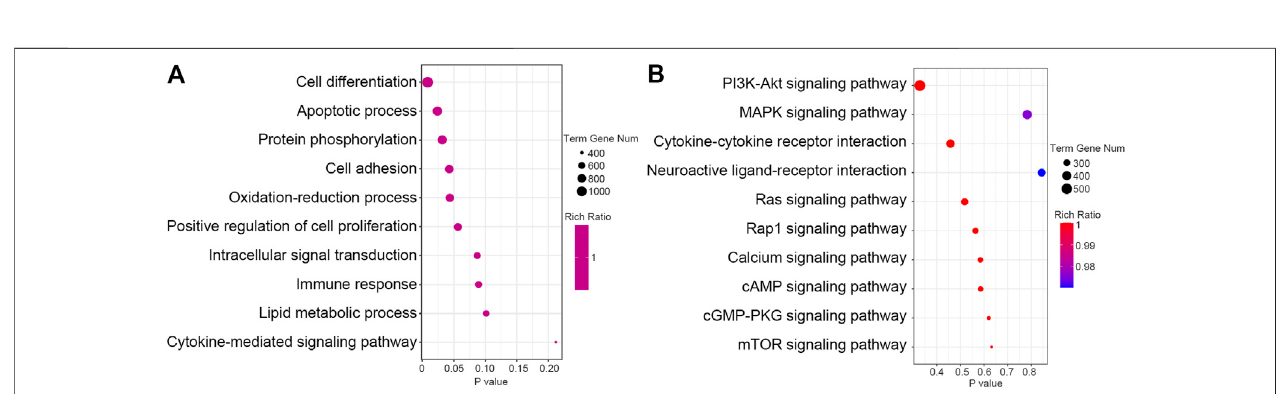
FIGURE 2 | Pathway analysis of the predict target genes of differential expressed miRNAs. (A) The GO biological process (BP) function of the predict target genes of differential expressed miRNAs was analyzed and the top 10 terms were listed. (B) KEGG pathway of the predict target genes of differential expressed miRNAs was analyzed and the top 10 pathways were